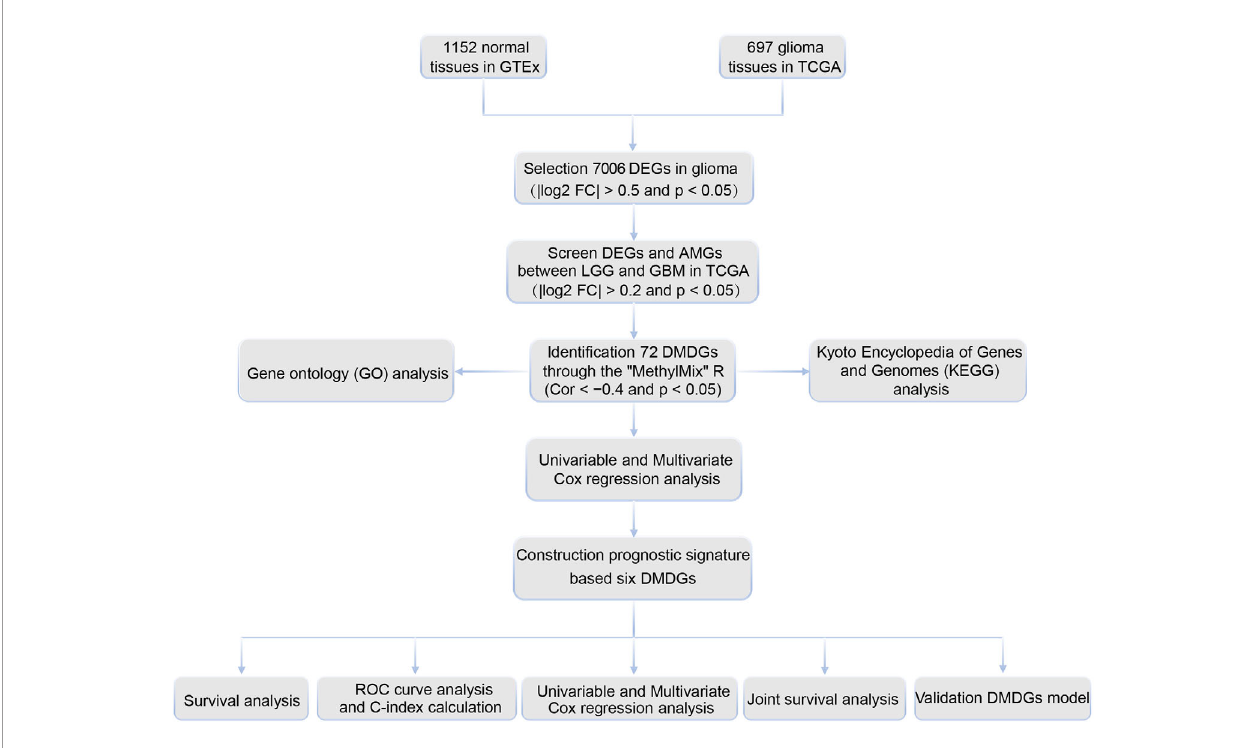
FIGURE 1 | Flow chart of the exploration of DMDGs in